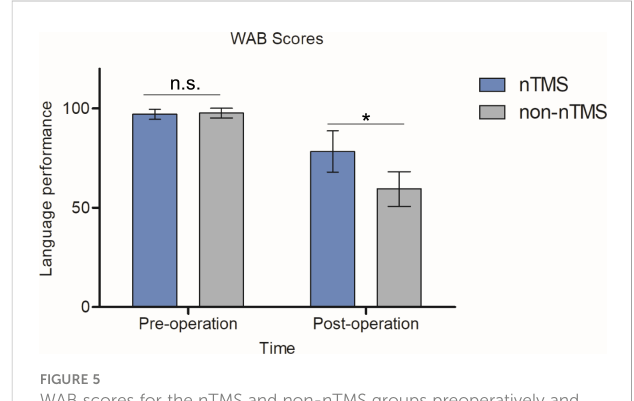
FIGURE 5 WAB scores for the nTMS and non-nTMS groups preoperatively and postoperatively. No signi fi cance was observed preoperatively ( P =0.658). We observed a signi fi cant postoperative improvement in the nTMS group relative to the non-nTMS group ( P =0.0321). The independent-samples t-test was employed. n.s. indicates no signi fi cant difference; *indicates P <